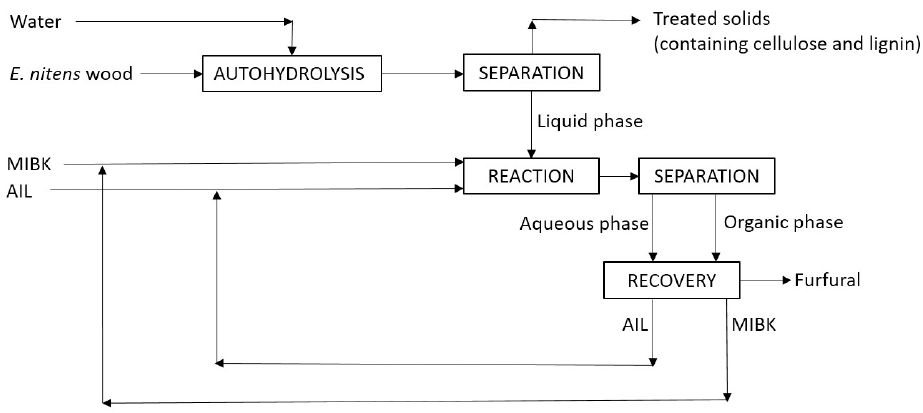
Figure 6. Scheme of wood processing for furfural production.